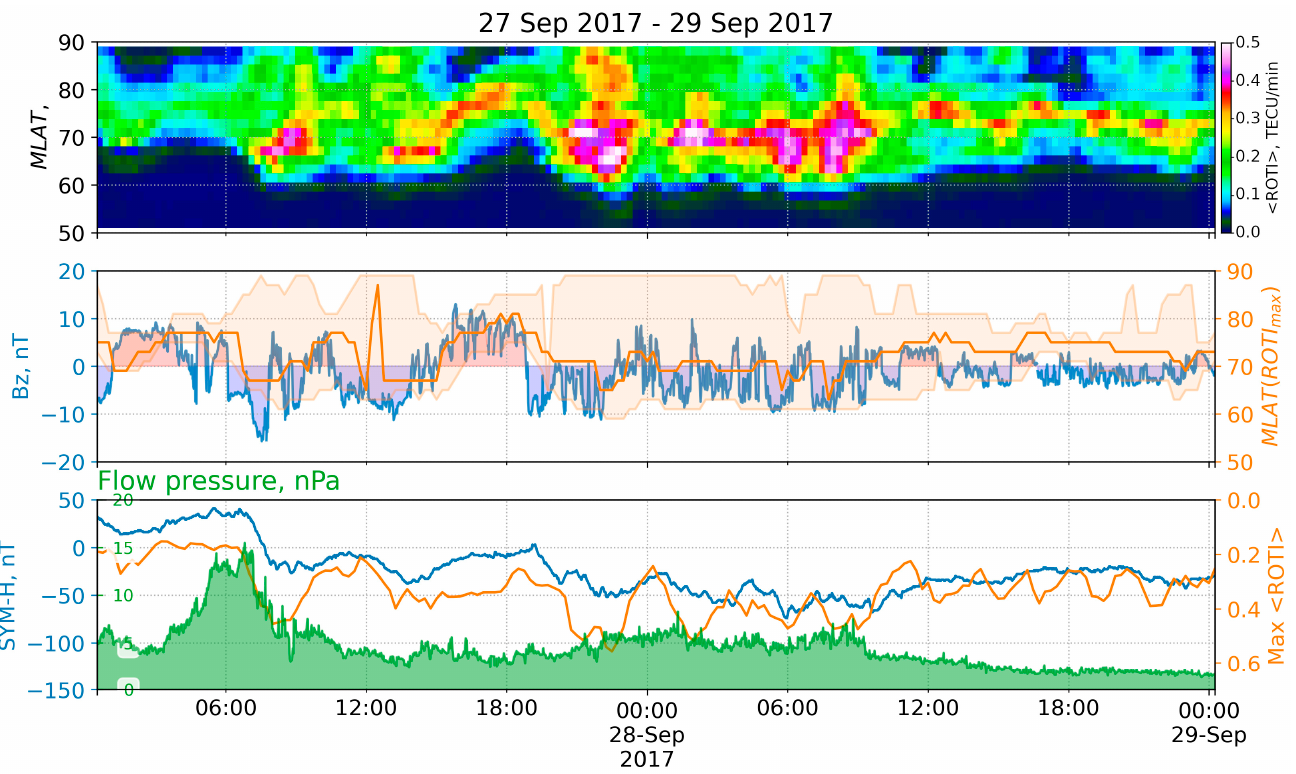
Figure 13. ROTI keogram and space weather parameters for the storm of 27 September 2017: ( top ) keogram of average ROTI (<ROTI> versus MLAT versus time); ( middle ) IMF Bz ( blue ), MLAT positions of maximum <ROTI> ( orange ), and values exceeding median ROTI at the moment ( orange filling ); ( bottom ) SYM-H index ( blue ), <ROTI> max ( orange ), and flow pressure ( green ).